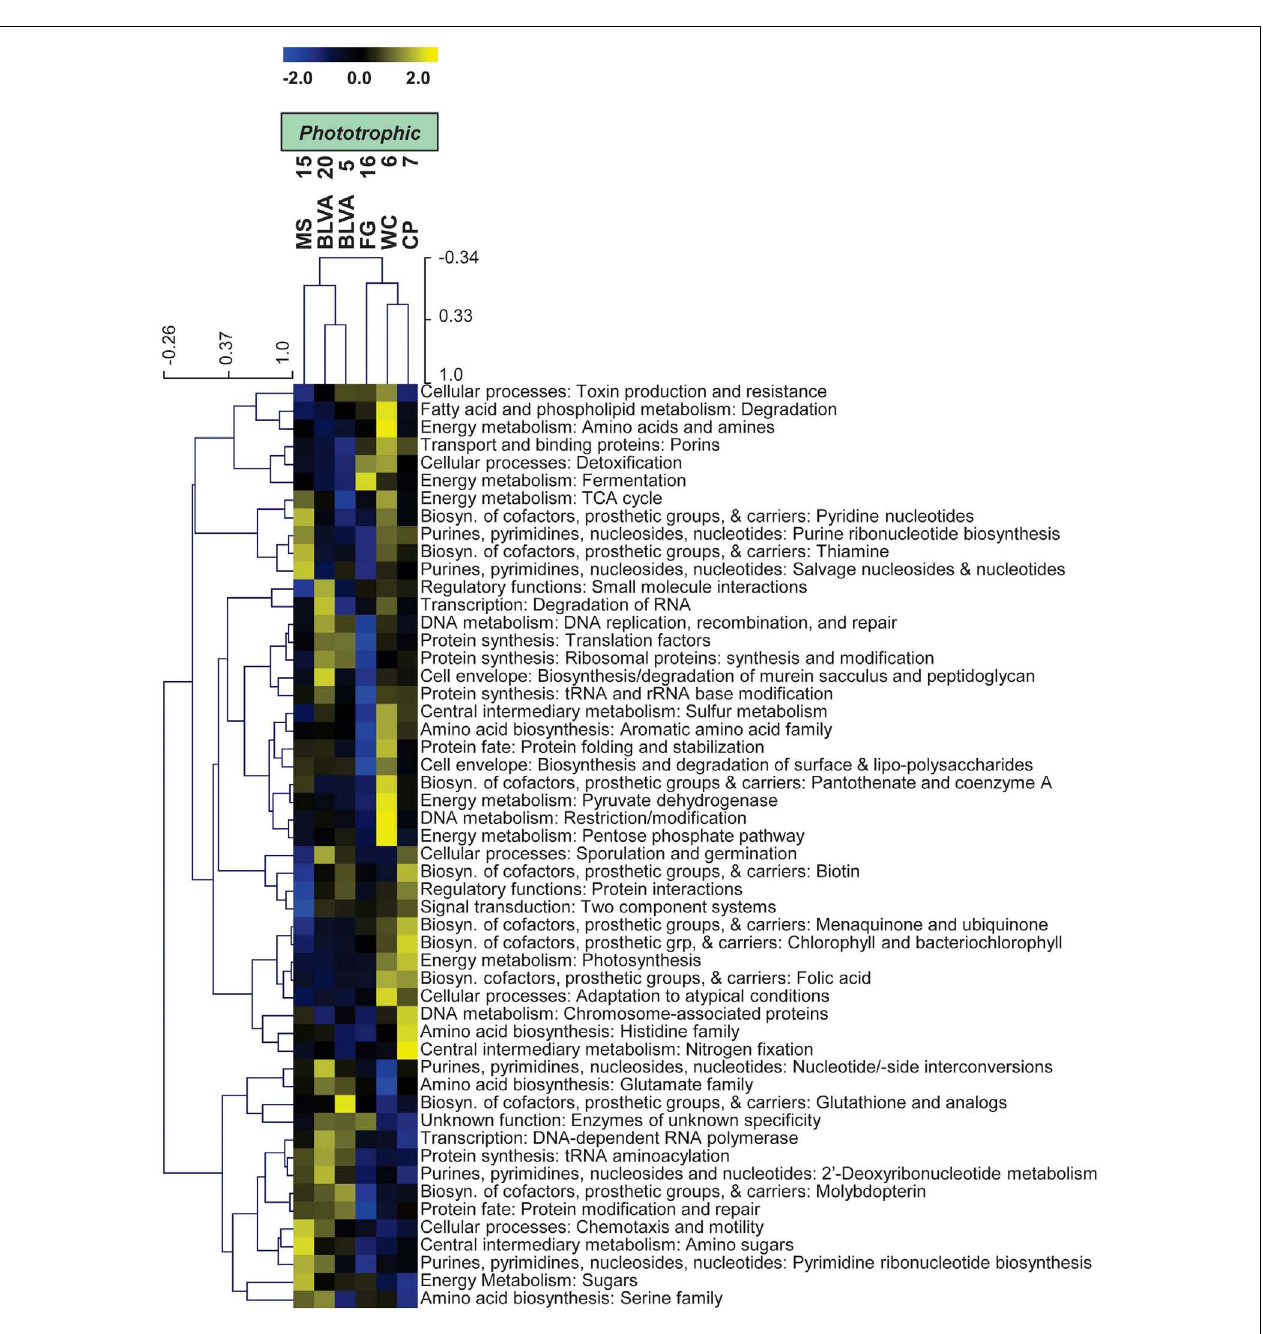
analysis by a few categories with high gene abundance. Pearson correlation was used as the distance measure for average linkage agglomerative